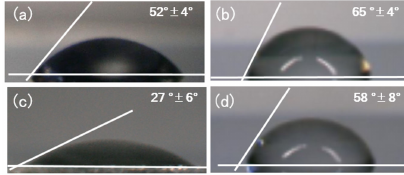
Figure 1. Contact angle of the water–stainless steel surface: ( a ) control, ( b ) ODPA-SAM-modified samples, ( c ) HOOC-DPA-SAM-modified samples, and ( d ) polyamine-tethered HOOC-DPA -SAM-modified samples. Table 1. Contact angle of the water–stainless steel surface. Sample